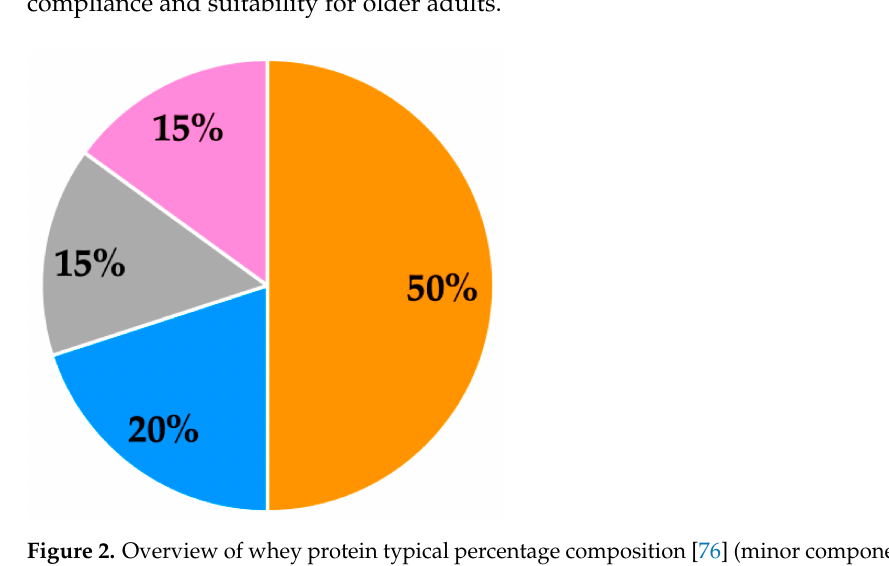
Figure 2. Overview of whey protein typical percentage composition [76] (minor components of whey protein are bovine serum albumin (BSA), immunoglobulins, lactoferrin and lactoperoxi- dase).